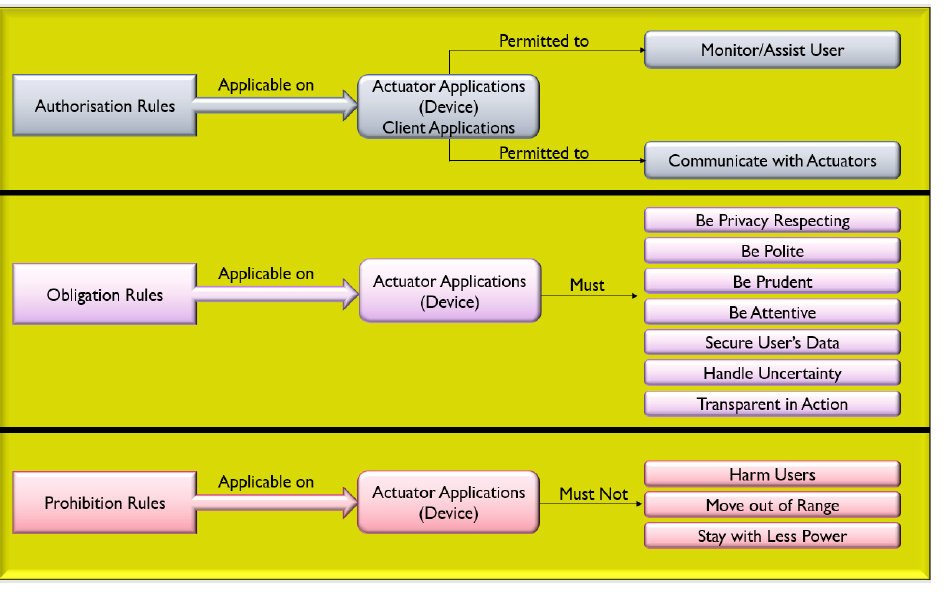
Figure 2. SANIJO